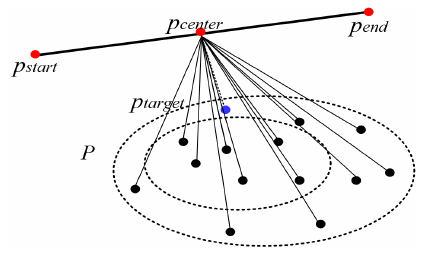
Figure 4. Determination of the target point by starting and end